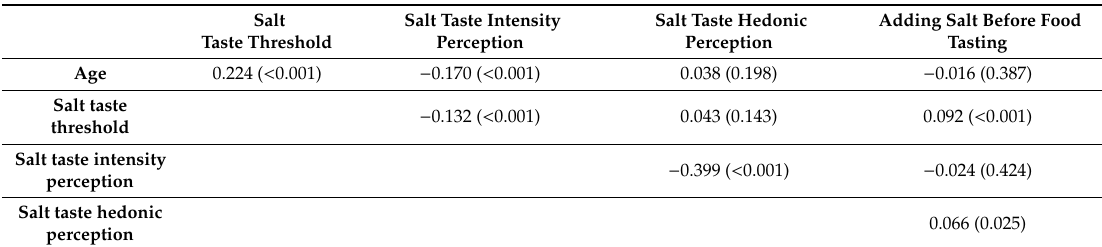
Table 2. Correlation between age, salt adding habit, threshold and suprathreshold salt taste perception, data presented are Spearman’s rho correlation coe ffi cients ( P values).